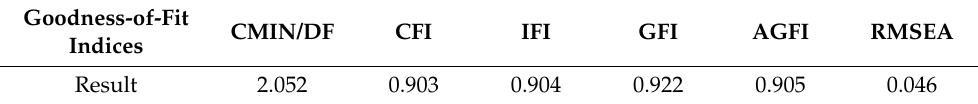
Figure 3. Partial mediating effect of negative affect experience between the rejection parenting style and the perceived cyberbullying.